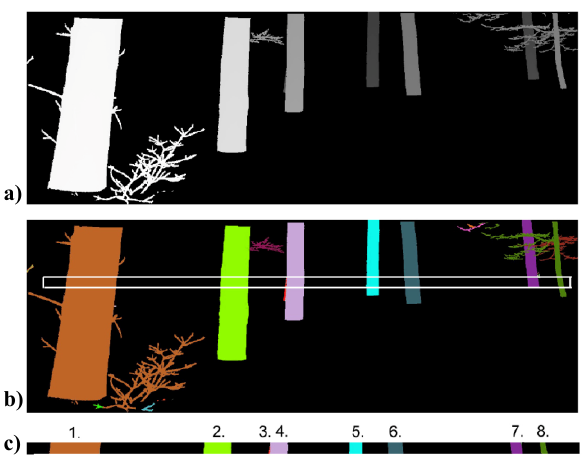
Figure 5. a) Grey value coded range image of a detailed scan;